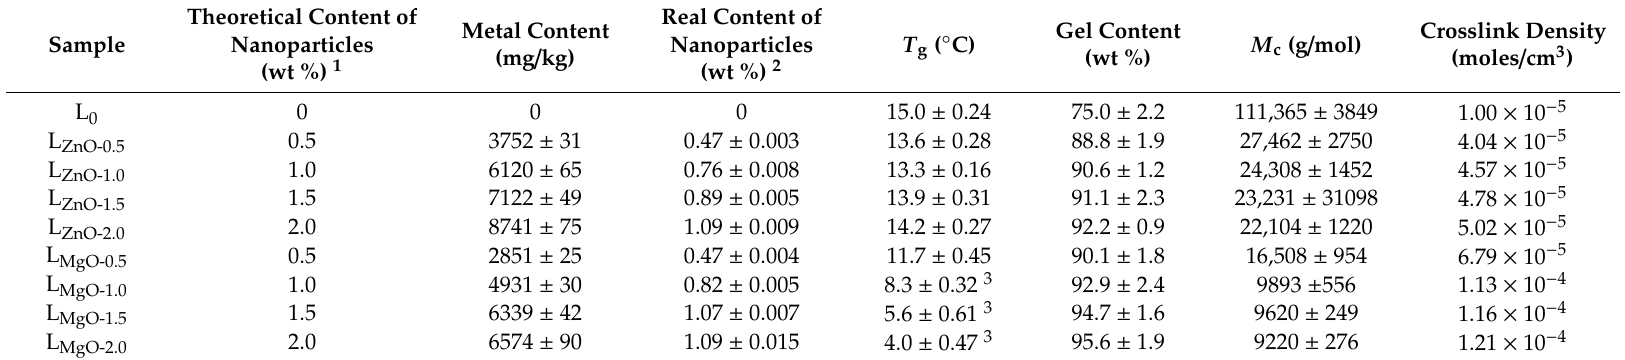
Table 5. E ff ect of type and content of inorganic nanoparticles on T g , gel content, M c and crosslink density of coating binder materials.